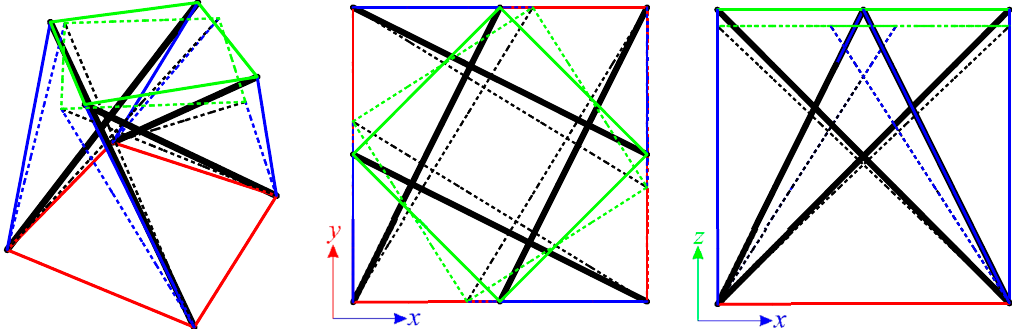
Figure 8. Infinitesimal mechanism of the single modified Quartex module.